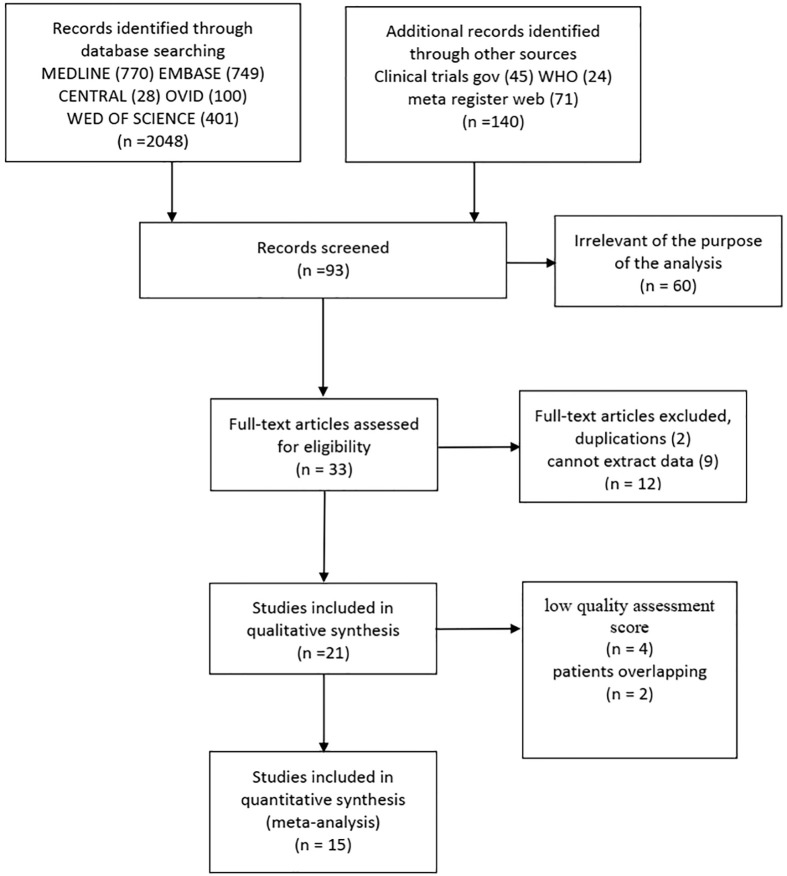
Selection of studies for inclusion in the systematic review.